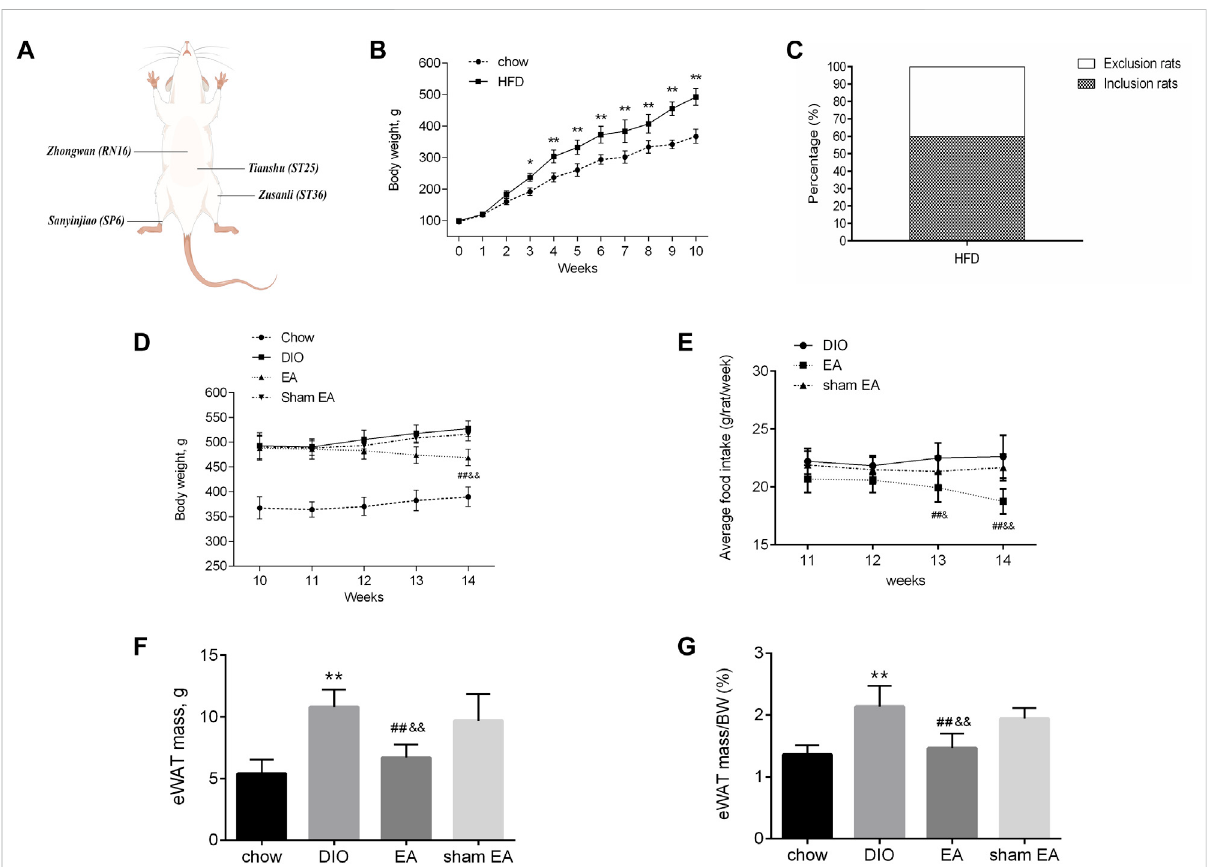
FIGURE 2 EA treatment decreased body weight and adipose tissue mass in the HFD-fed rats. (A) The location of prescribed acupoints, (B) BW from the chow and HFD groups from week 0to week 10, (C) proportion of rats gained 20%or more than theaverage BW of the chow group, (D) BW from the fourgroupswithinweek10toweek14, (E) averagefoodconsumptionperratwithinweek11toweek14, (F) eWATmass,and (G) eWAT/BWratiofrom thefourgroups.AlldataareexpressedasMean±SD( n =10ratspergroup),** p < 0.01vs.chow; ## p < 0.01vs.DIO; && p < 0.01vs.shamEA.HFD, high-fat diet; EA, electroacupuncture; DIO, diet-induced obesity; BW, body weight; eWAT, epididymal white adipose tissue. EA treatment reversed HFD-induced morphological